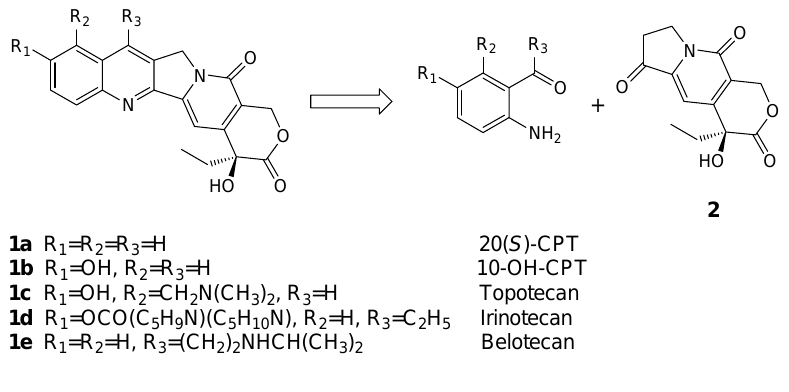
Figure 1. Structures of 20( S )-camptothecin and its clinic